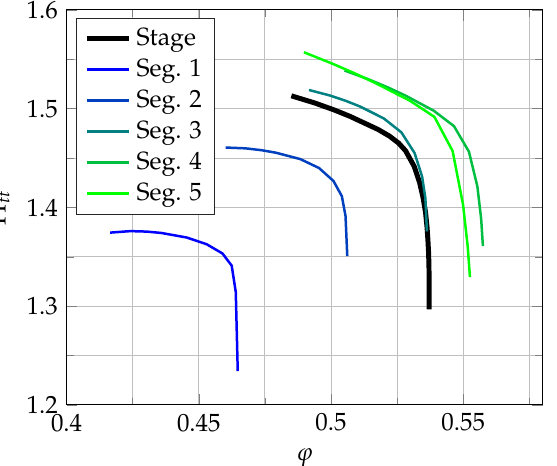
Figure 9. Performance map of the overall fan stage and for each of five radial segments. Counting starts at the hub